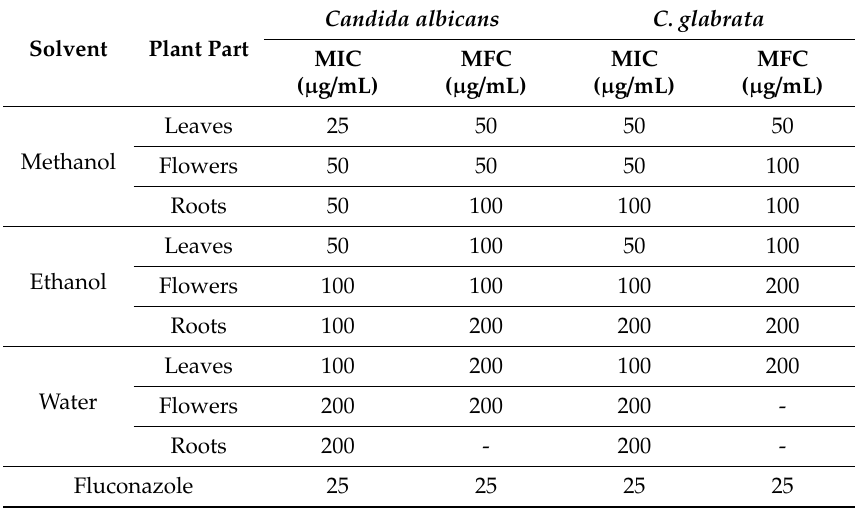
Table 4. Antifungal activity of the Nepeta juncea extracts.